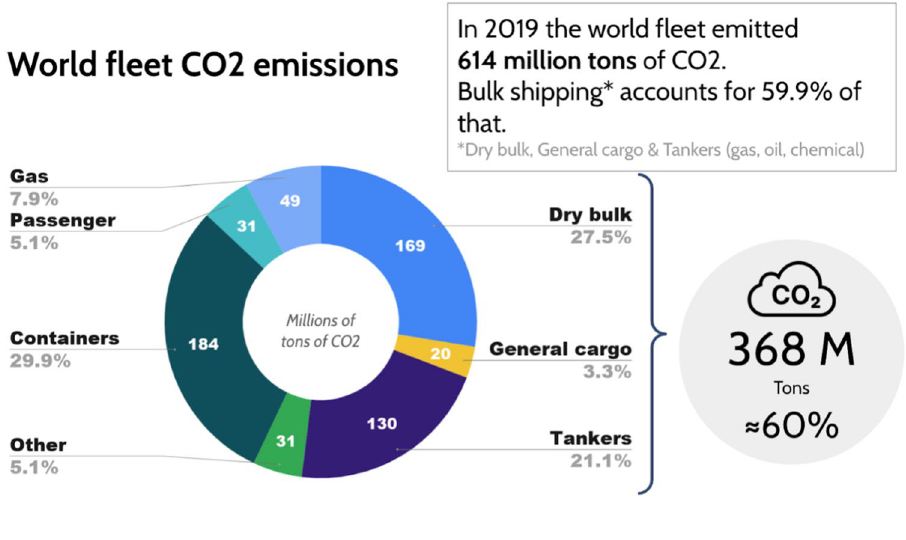
Fig. 25 Yearly energy con- sumption of ships in relation to diesel and gasoil consump- tions in 2016, data